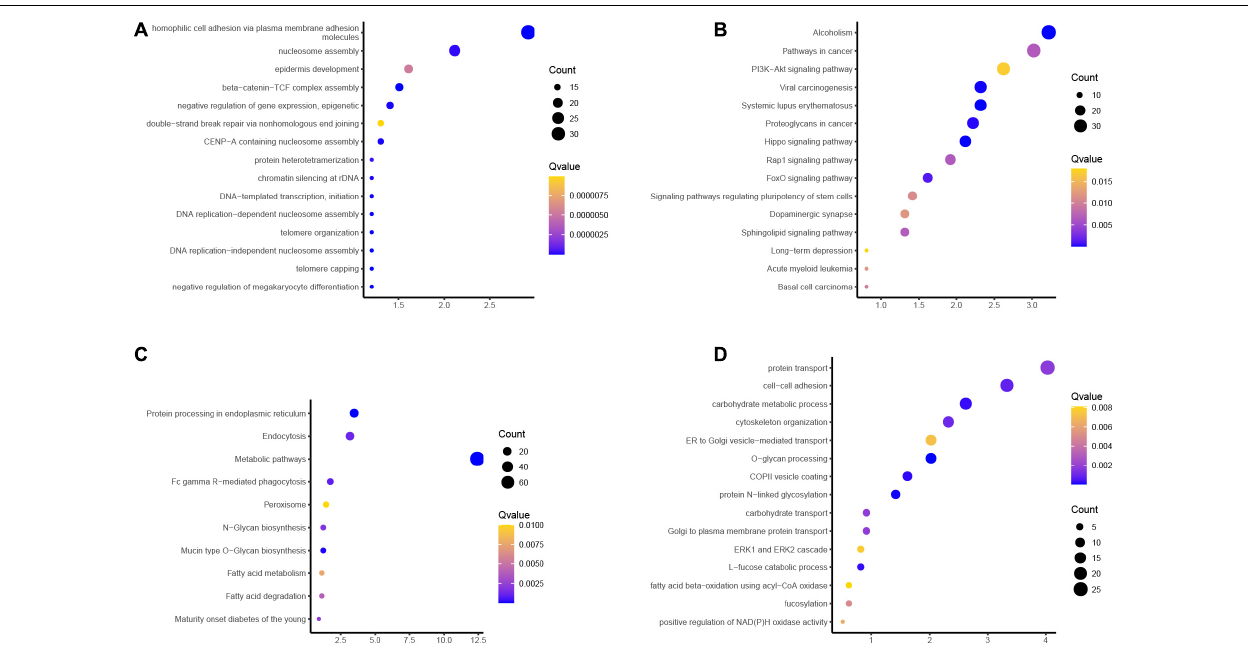
FIGURE 4 | Bioinformatics analyses of differentially expressed genes (DEGs) between esophageal adenocarcinoma (EA) and esophageal squamous cell carcinoma (ESCC) samples. (A,B) Gene Ontology (GO) functions and Kyoto Encyclopedia of Genes and Genomes (KEGG) analysis of the upregulated genes in EA compared to ESCC. (C,D) GO functions and KEGG analysis of the common downregulated genes in EA compared to